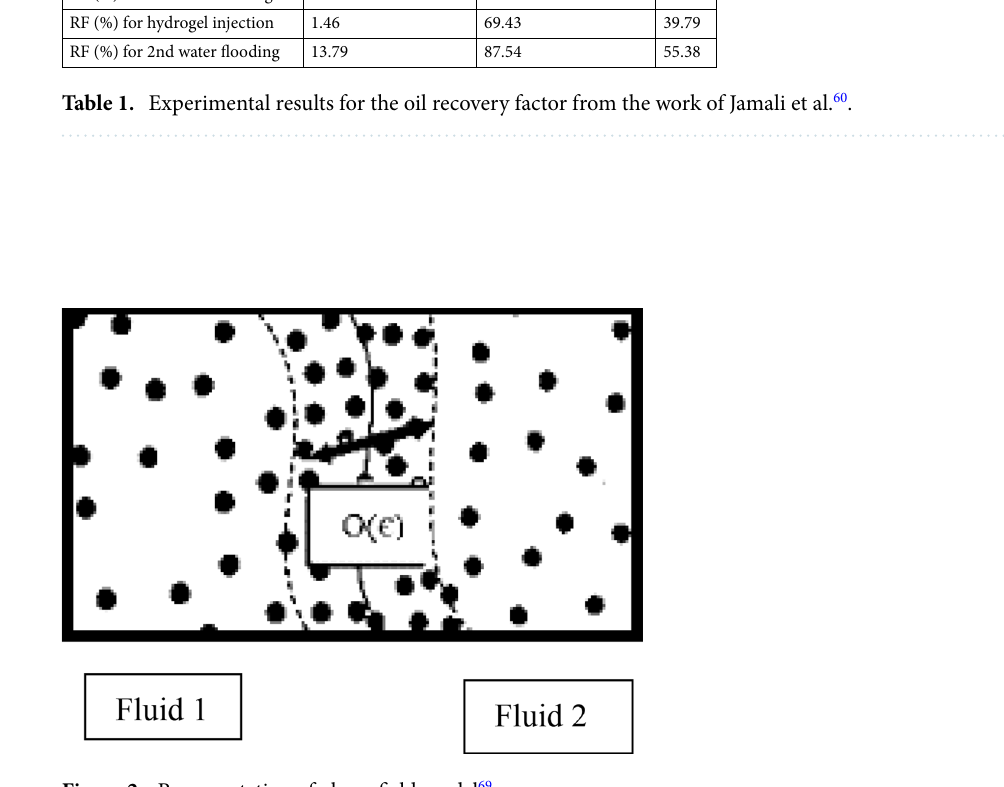
Figure 2. Representation of phase-field model 69